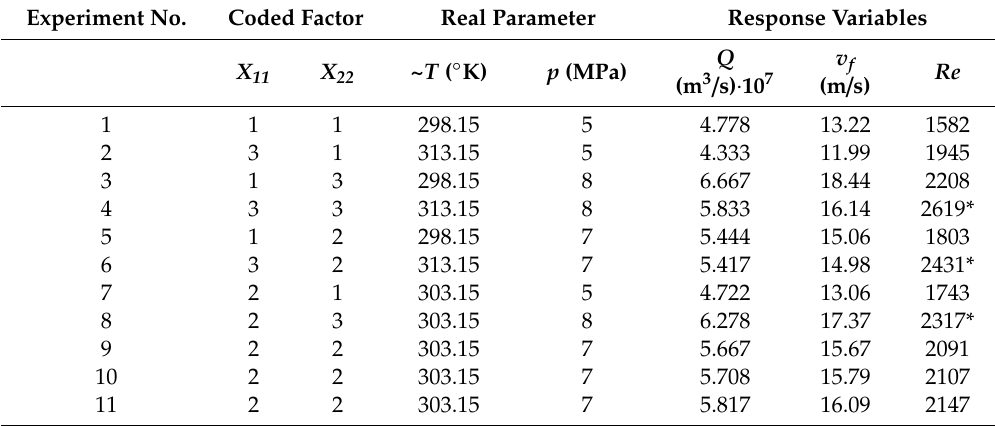
Table 8. Research plan and results of the experiments; * Re > 2300 turbulent flow is considered. Experiment No.